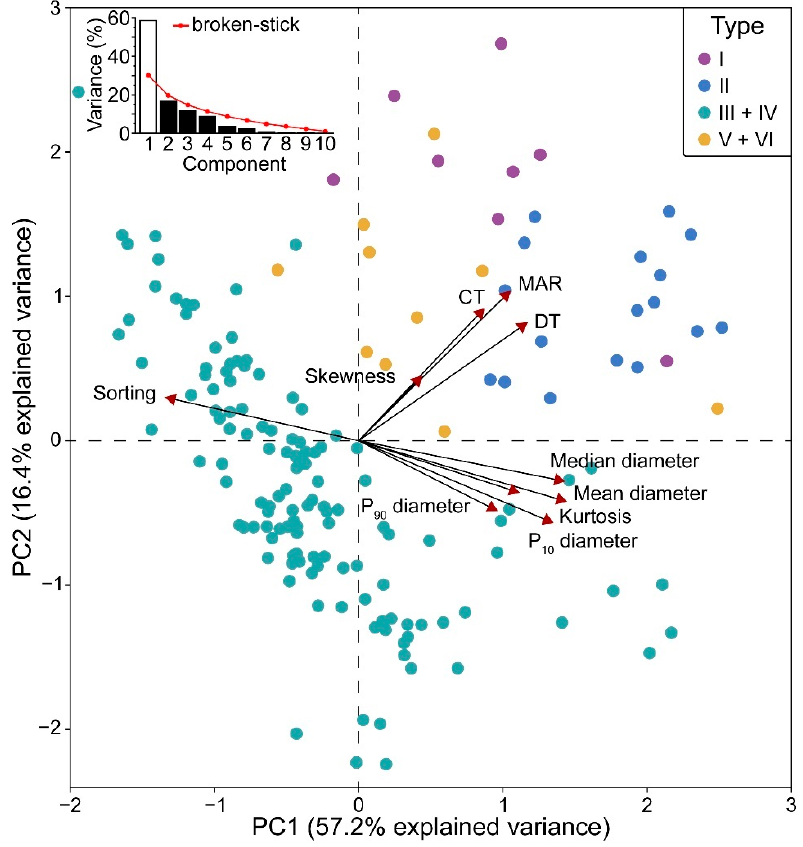
Figure 7. PCA biplot of sedimentological and grain-size data. CT—calcite layer thickness; DT—dark layer thickness; MAR—mass accumulation rate.